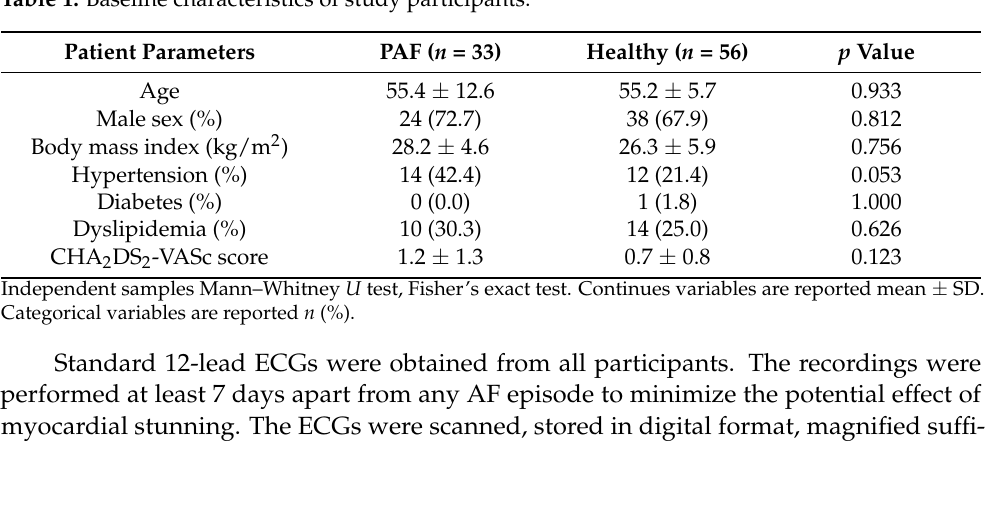
Table 1. Baseline characteristics of study